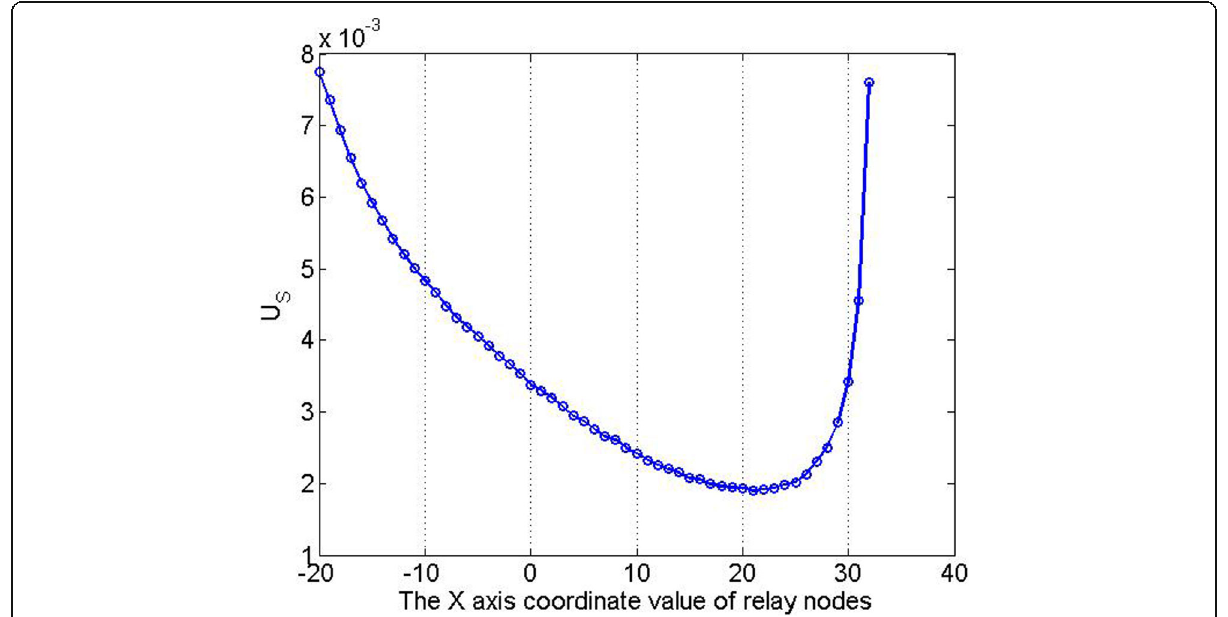
Fig. 6 The source node total payment U S Vs the location change of cooperative relay nodes